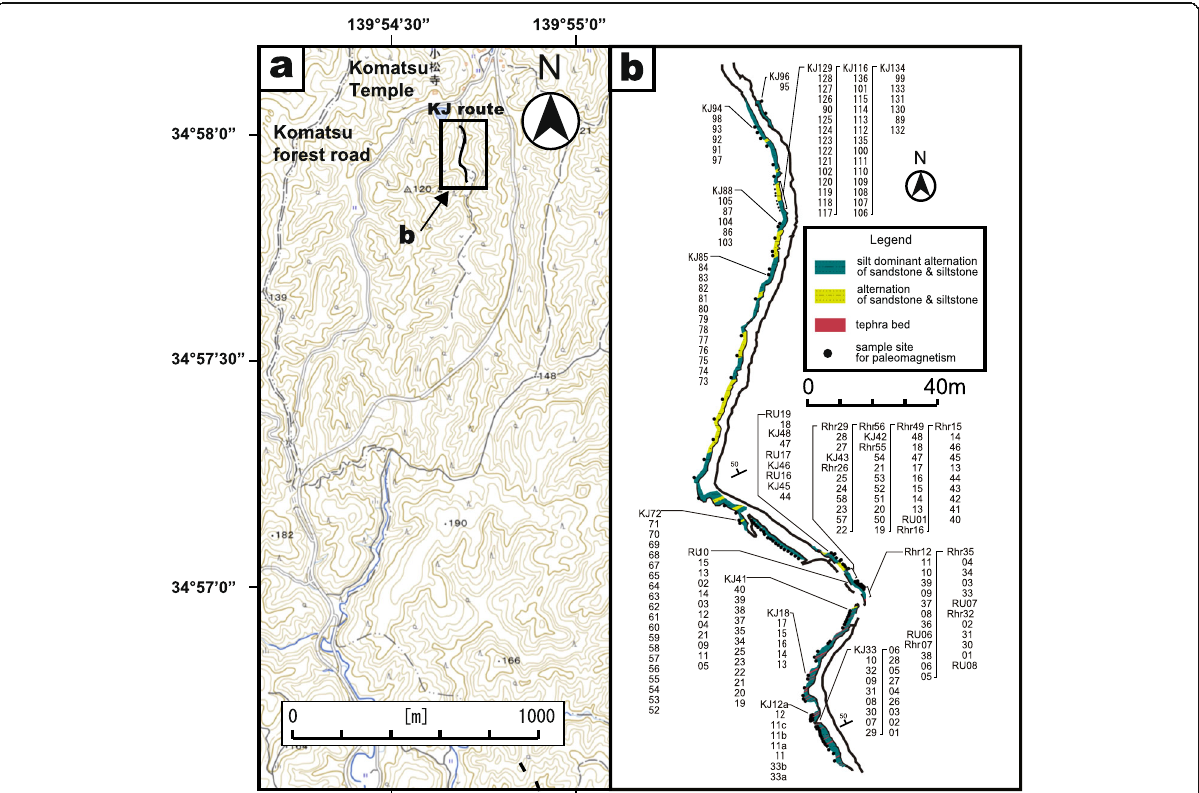
Fig. 2 Location of the study area. a Location of the study area and its vicinity. The box indicates the KJ route area used in this study. b Locations of sampling sites and lithologies along a branch creek of the Seto river. Low-resolution sampling sites are shown by black dots, and high- resolution sites corresponding to the geomagnetic reversal boundaries are shown by black bars. Detailed descriptions for the horizons of the high-resolution sites are shown in S. Figure